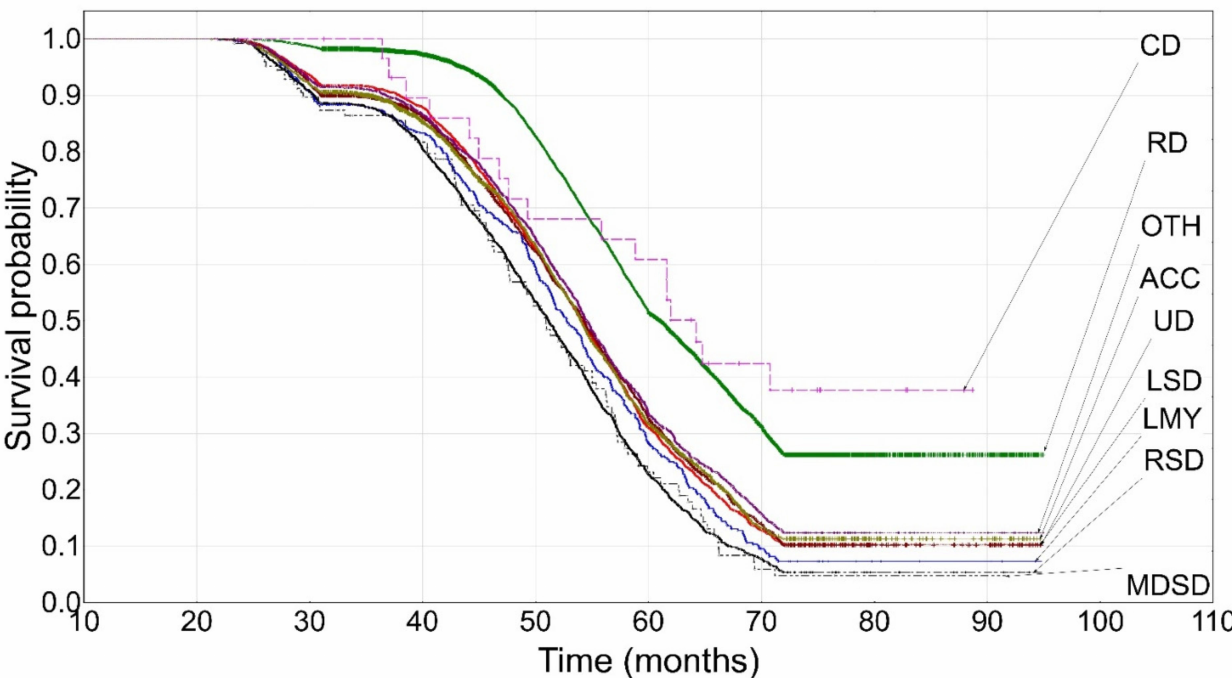
Figure 3. The Kaplan–Meier survival probability until the third lactation. UD—udder